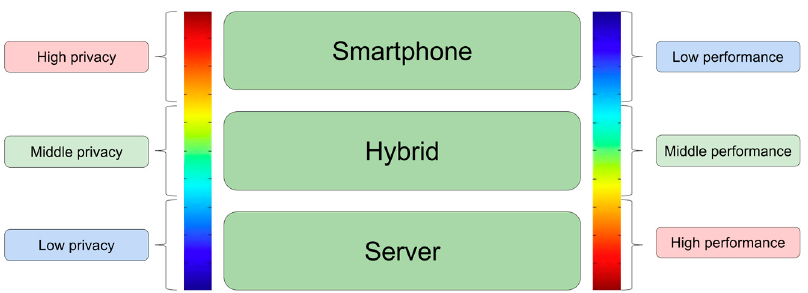
Figure 16. Analytics location models.